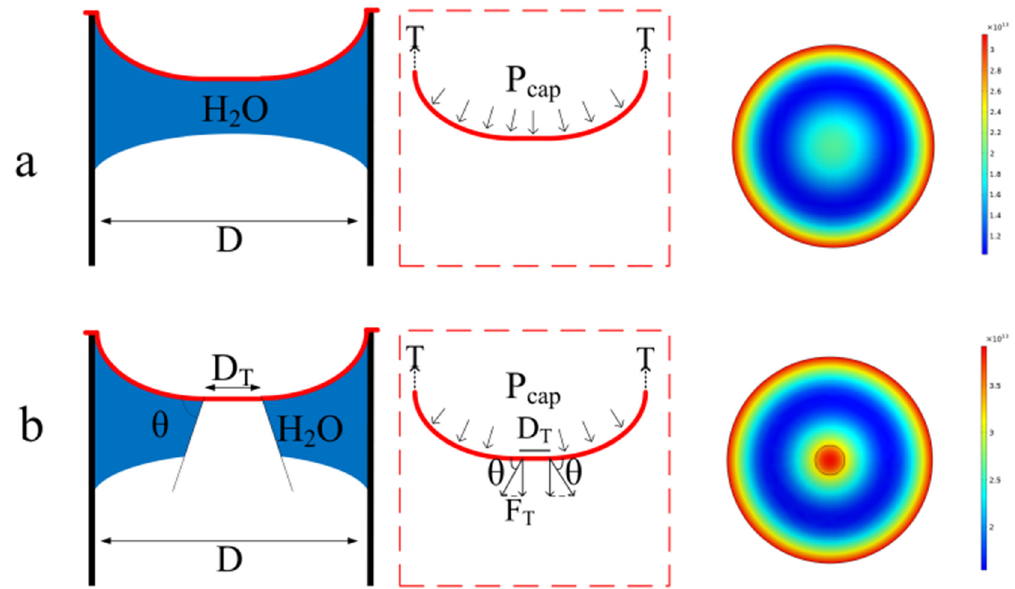
Figure 2. Two-stage force diagram and simulation diagram. ( a ) The bottom surface of graphene is completely covered by liquid. ( b ) Three-phase interface formation stage.